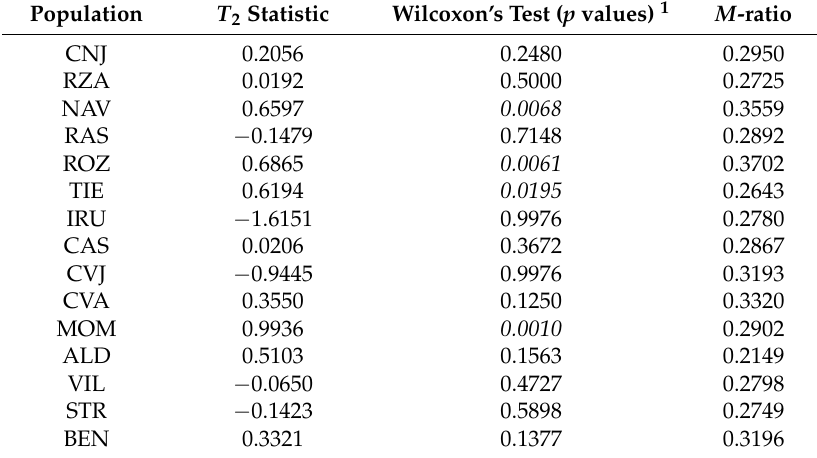
− 0.9445 0.9976 0.3550